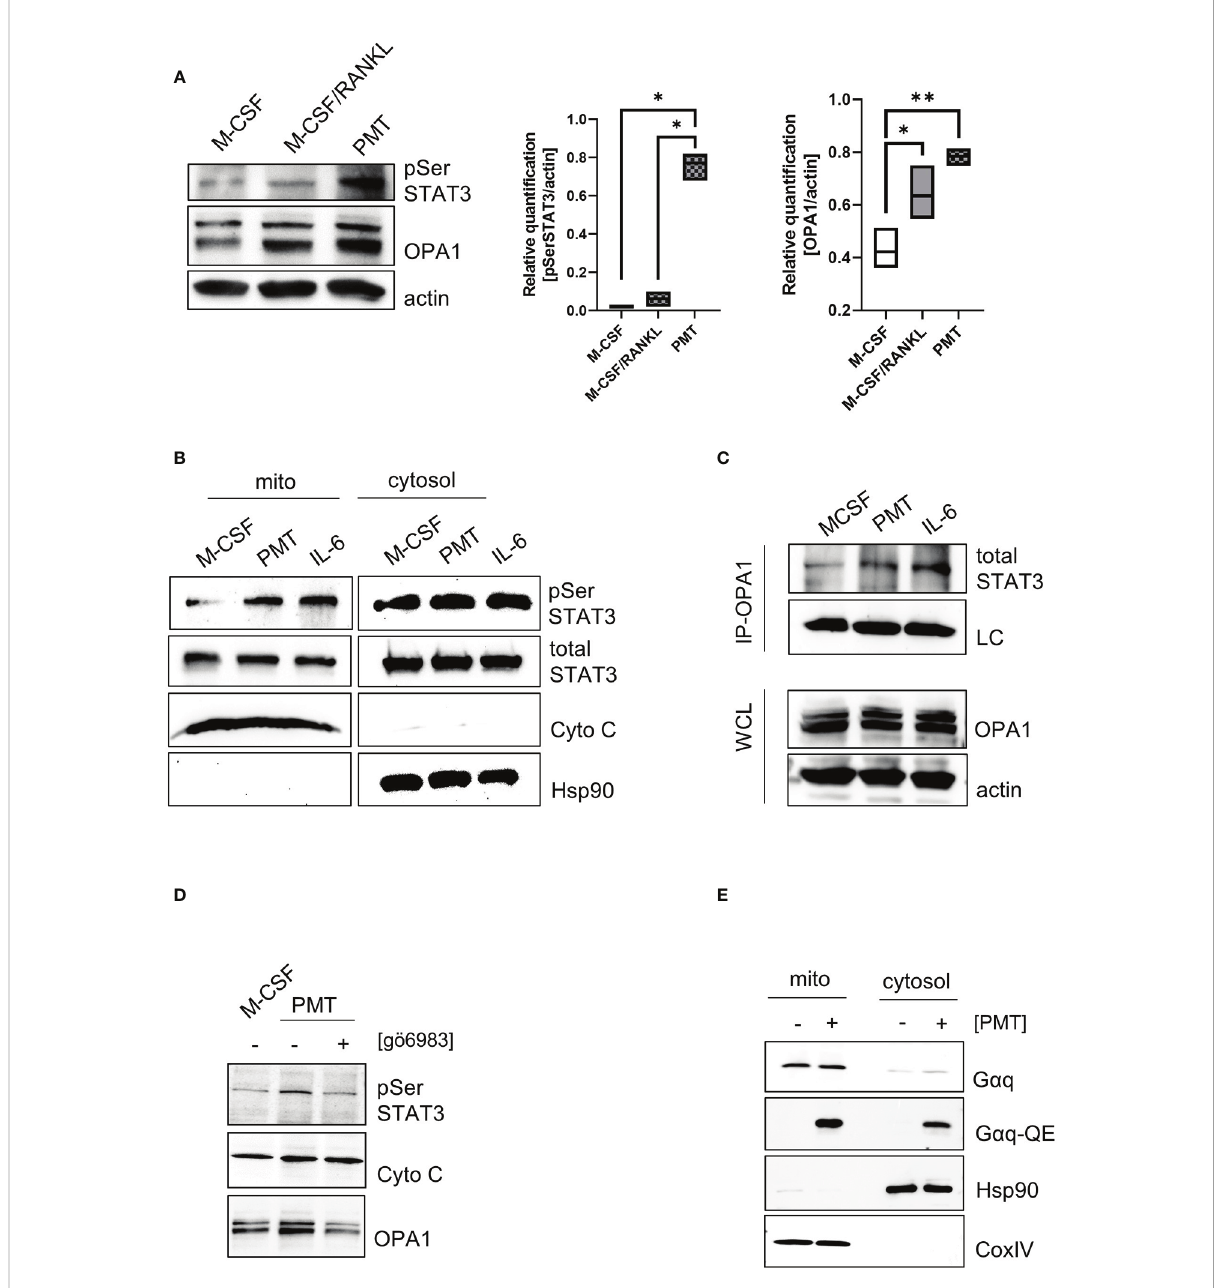
FIGURE 3 G a q supports STAT3 mitochondrial translocalisation and stabilises OPA1 expression. (A) Whole cell lysates showing STAT3 serine phosphorylation and OPA1 expression on day 3 of differentiation. Quanti fi cation of pSer STAT3 and Opa1 levels relative to actin which was used as a loading control (n=4). Statistical analysis was done using a 1-way ANOVA test. (B) Localisation and post-translational modi fi cations of STAT3 in mitochondrial and cytoplasmic fractions of BMDM (n=4). (C) Whole cell lysates of BMDM were prepared after 3 h of stimulation with IL-6 or PMT and either used directly as WCL control or subjected to immunoprecipitation with a monoclonal OPA1 antibody. Membranes were immunoblotted using an antibody recognising total STAT3. As input control, a light chain speci fi c antibody against the IP antibody was used. Equal OPA1 levels were veri fi ed by using WCL samples and blotting against OPA1 and actin as loading controls (n=4). (D) Serine phosphorylation of STAT3 and OPA1 expression was determined in mitochondrial fractions in the presence and absence of the pan-PKC inhibitor gö6983 (n=3). (E) Biochemical fractionation and subsequent analysis of mitochondrial and cytoplasmic fractions for deamidated and total levels of G a q, respectively (n=4). Hsp90 and COXIV were used as purity controls for cytoplasmic and mitochondrial